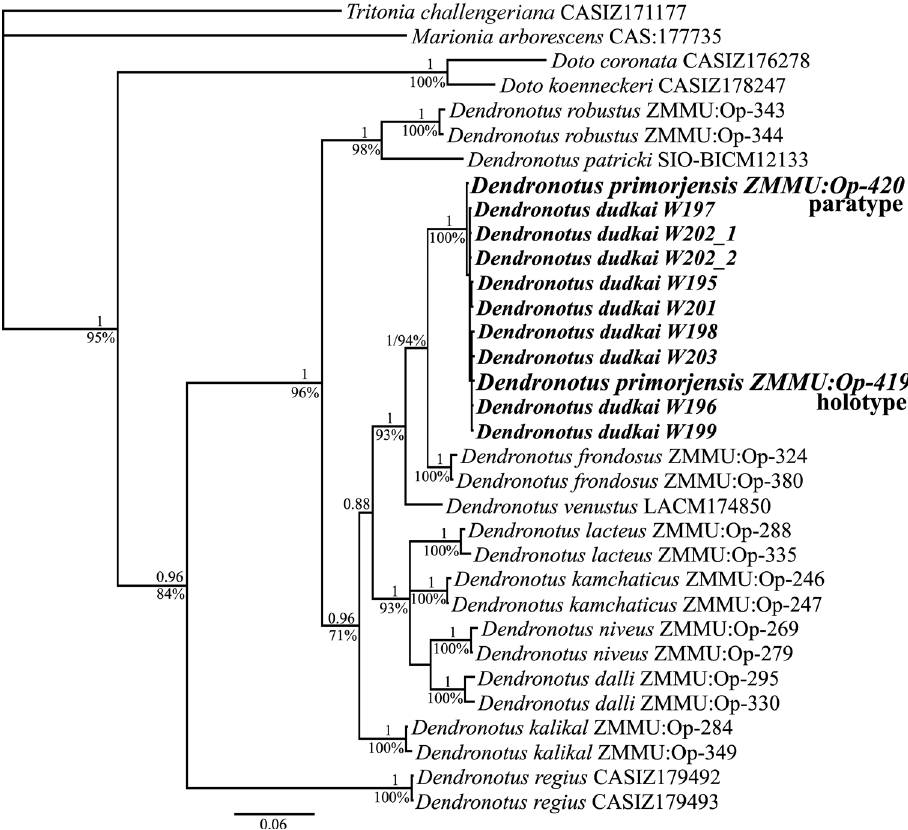
Figure 2. Phylogenetic tree based on combined molecular data (COI + 16S + 28S) represented by Bayesian Inference. Numbers above branches represent posterior probabilities from BI. Numbers below branches indicate bootstrap values for Maximum